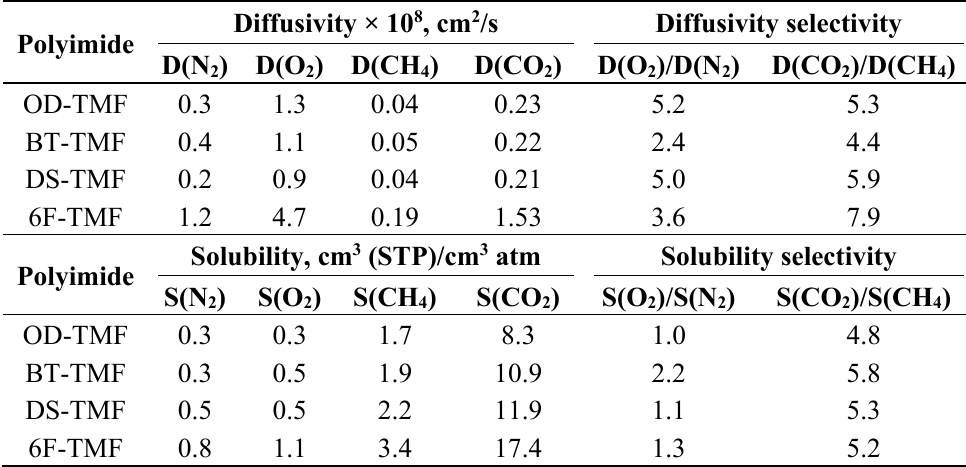
Table 4. Gas diffusivity and solubility coefficients calculated from Equations (3) and (4) using the permeability coefficients measured at 35 °C and 2 atm for the